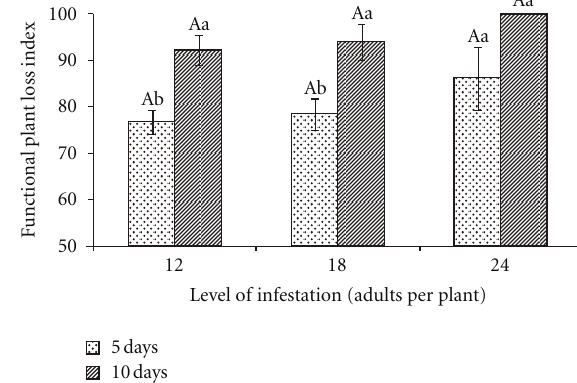
Figure 4: Functional plant loss indexes (%) after 5 or 10 days of exposure to 3 levels of infestation by M. spectabilis adults. Bars with the same lowercase letters within the level of infestation and bars with the same capital letters between the levels of infestation did not di ff er by Tukey